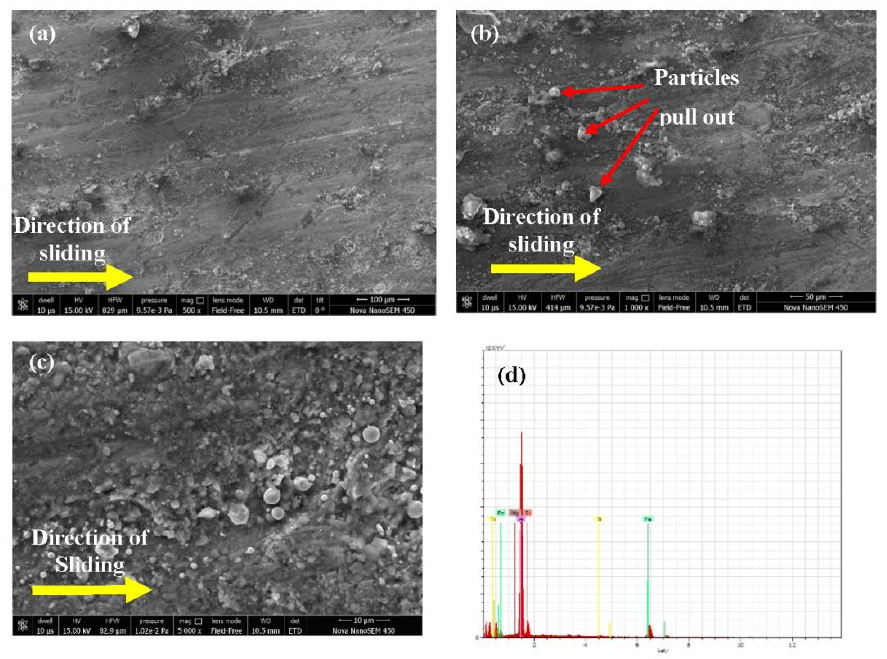
Fig. 13. (a), (b), (c) FESEM images of Al-Si-Mg/TiB 2 composites at 12 h ageing time, 2.5 m/s sliding speed and 14.71 N, (d) EDS mapping of Al-Si-Mg/TiB 2 composites at 12 h ageing time, 2.5 m/s sliding speed and 14.71